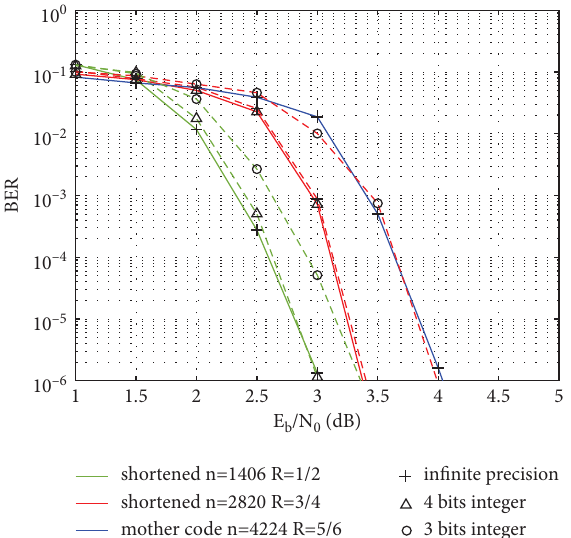
Figure 11: BER performance of MSA LDPC decoding with various quantization schemes. n � 1008 and R � 2/3.